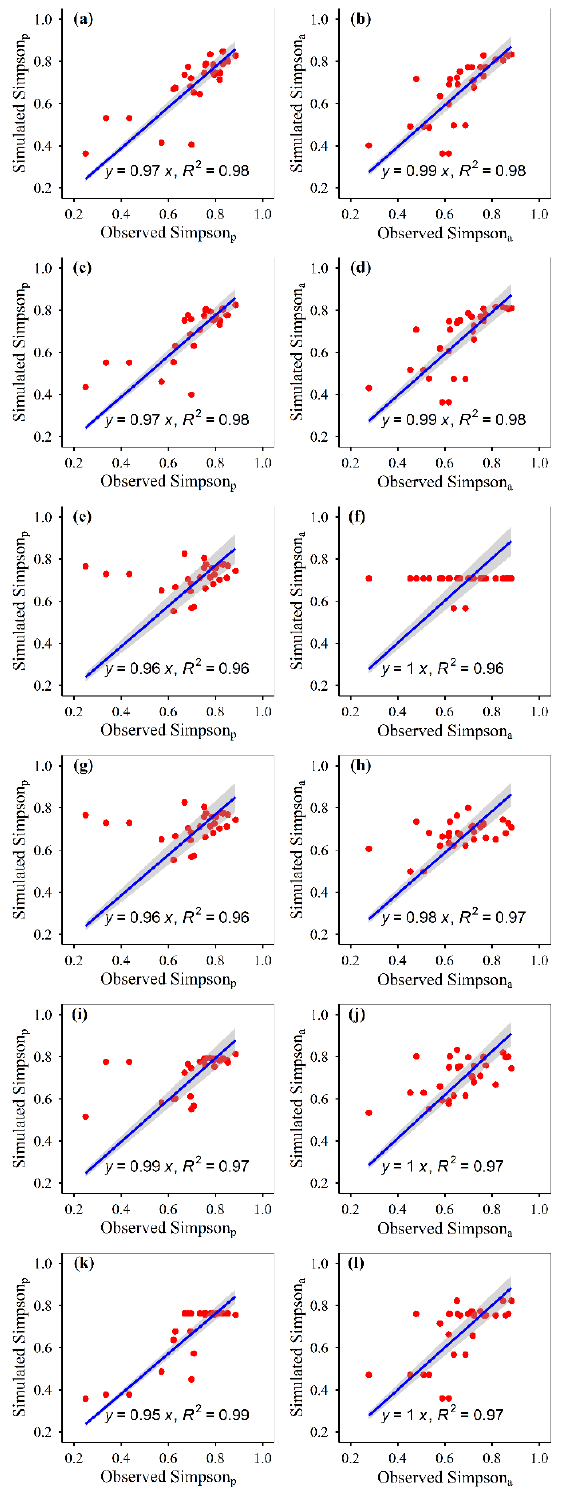
Figure 4. Correlations between the simulated and observed Simpson of the plant community under fencing ( a , c , e , g , i , k ) and grazing ( b , d , f , h , j , l ) scenes, for random forest ( a , b ), generalized boosted re- gression ( c , d ), artificial neural network ( e , f ), multiple linear regression ( g , h ), support vector machines ( i , j ) and recursive regression trees ( k , l ). The solid lines indicate the linear fitted lines between the simulated and observed Simpson. Simpson p : potential Simpson; Simpson a : actual Simpson. All the regressions were significant at p <